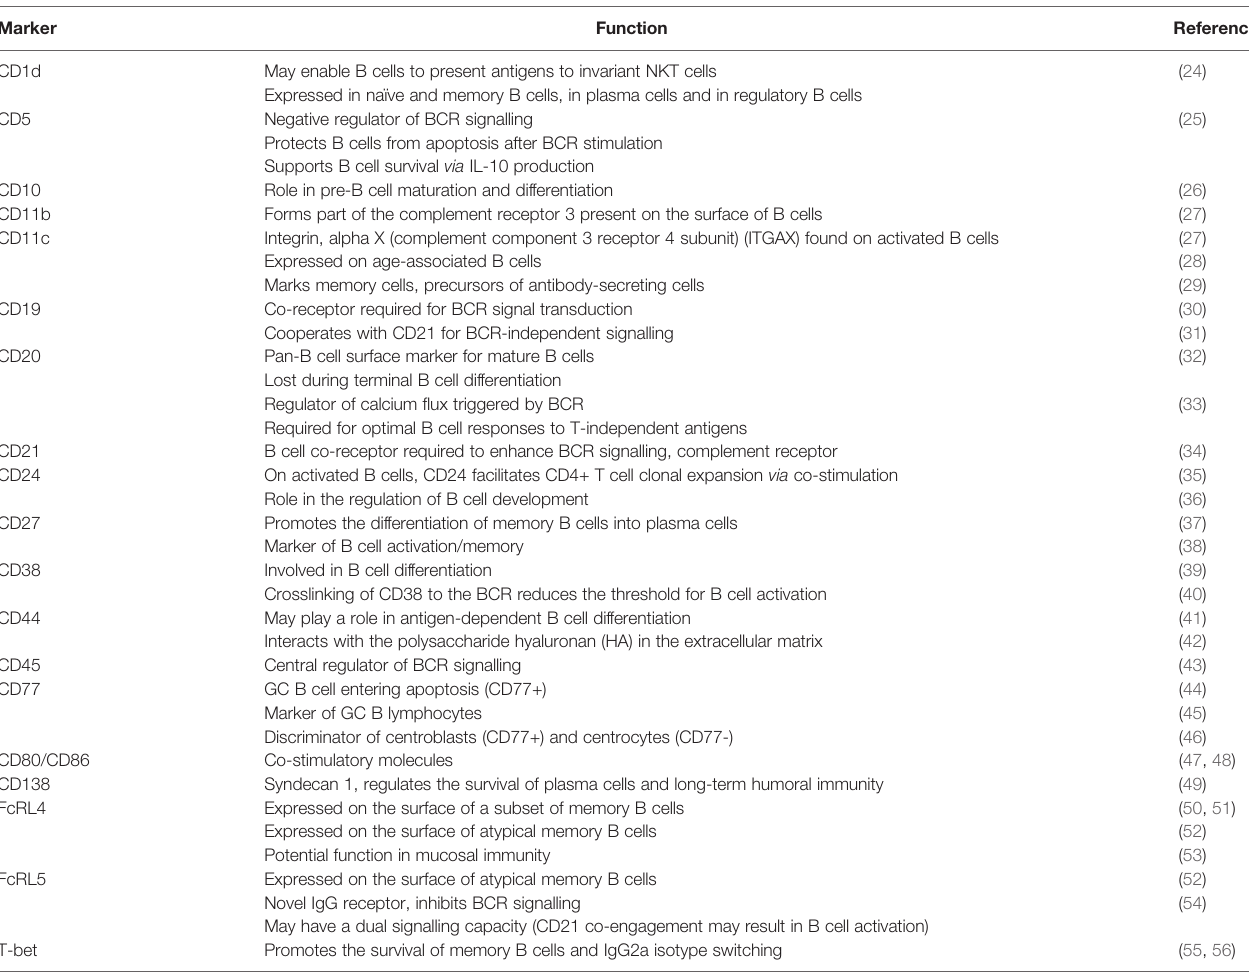
TABLE 1 | Common proteins that are used to differentiate B cell